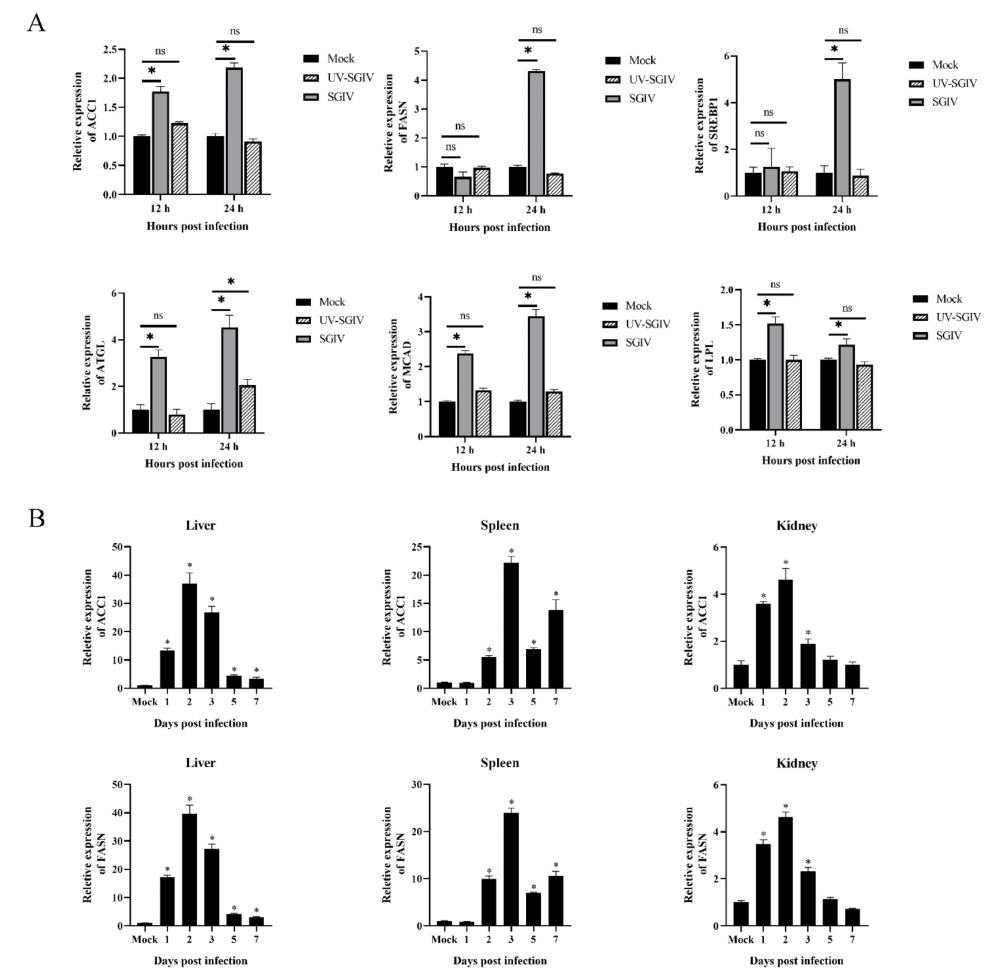
Figure 1. The mRNA expression levels of lipid relative genes post SGIV infected in vivo/vitro. Expression levels of lipid related genes in GS cells during SGIV infection ( A ). mRNA expression of ACC1 and FASN in different tissues of grouper during SGIV infection ( B ). n = 3, data are expressed as means ± SD, * indicates p < 0.05, ns for no significant